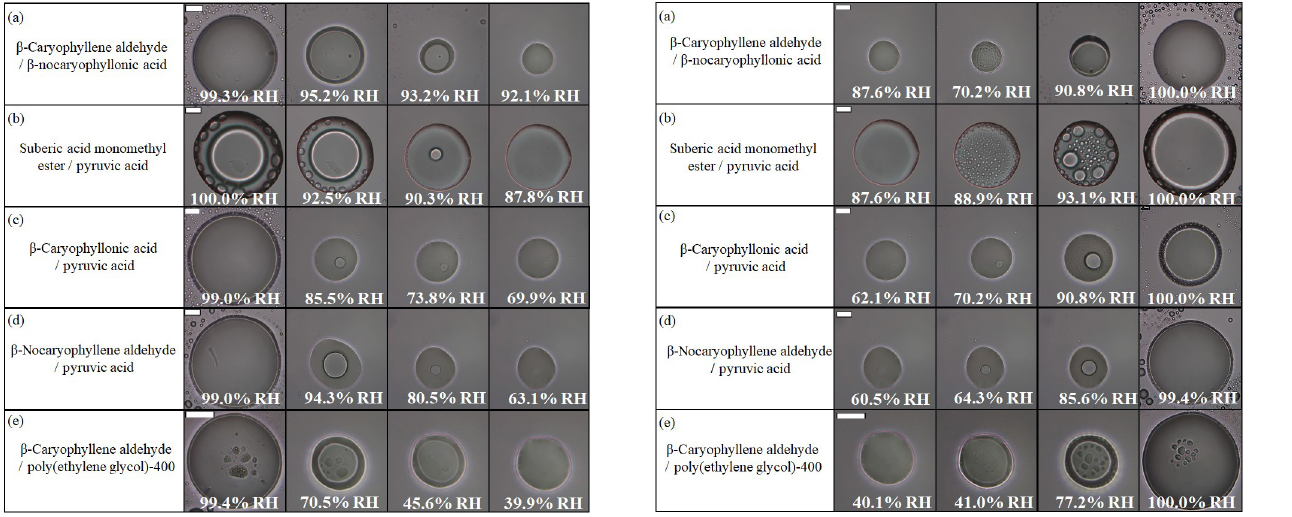
Figure 4. Optical images of two-component particles for de- creasing RH: (a) β -caryophyllene aldehyde– β -nocaryophyllonic acid, (b) suberic acid monomethyl ester–pyruvic acid, (c) β - caryophyllonic acid–pyruvic acid, (d) β -nocaryophyllene aldehyde–pyruvic acid, and (e) β -caryophyllene aldehyde– polyethylene glycol-400. The last columns indicate the lower RH boundary for LLPS (LLPS lower ) with decreasing RH. The scale bar is 20µm.